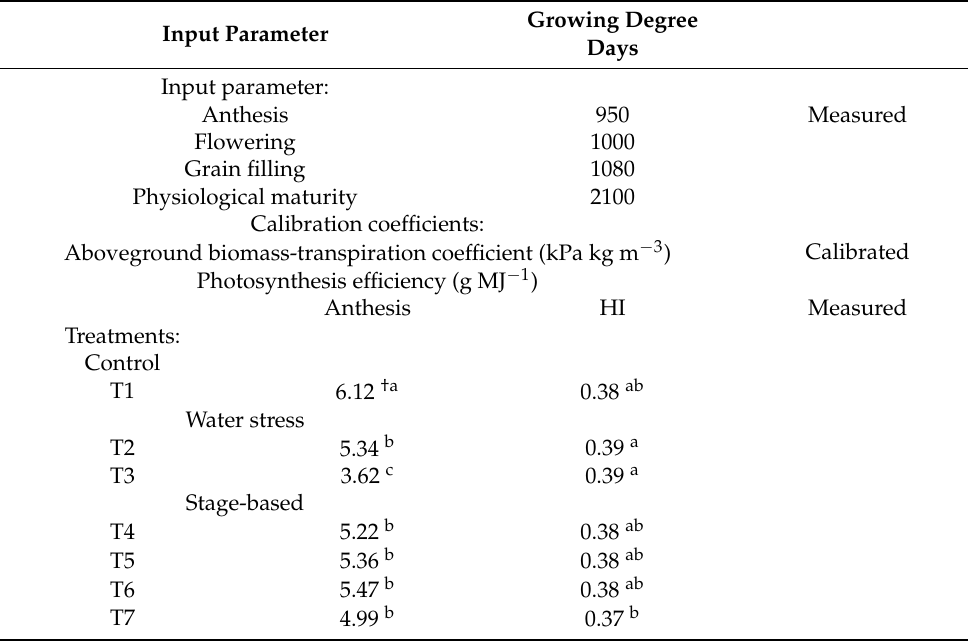
Table 6. The values of input parameters used in the calibration process in the first growing season for each treatment.